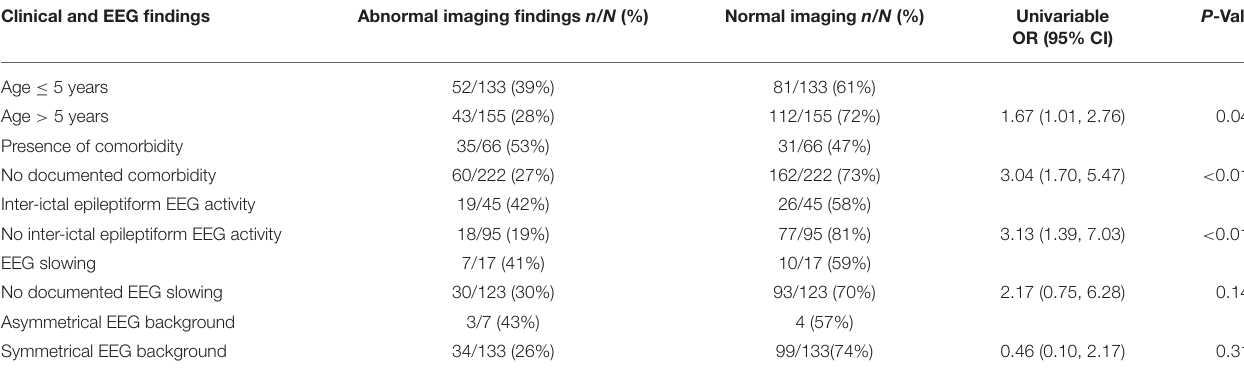
TABLE 2 | The relationship between electroencephalographic (EEG) and clinical features and abnormal imaging findings. Clinical and EEG findings